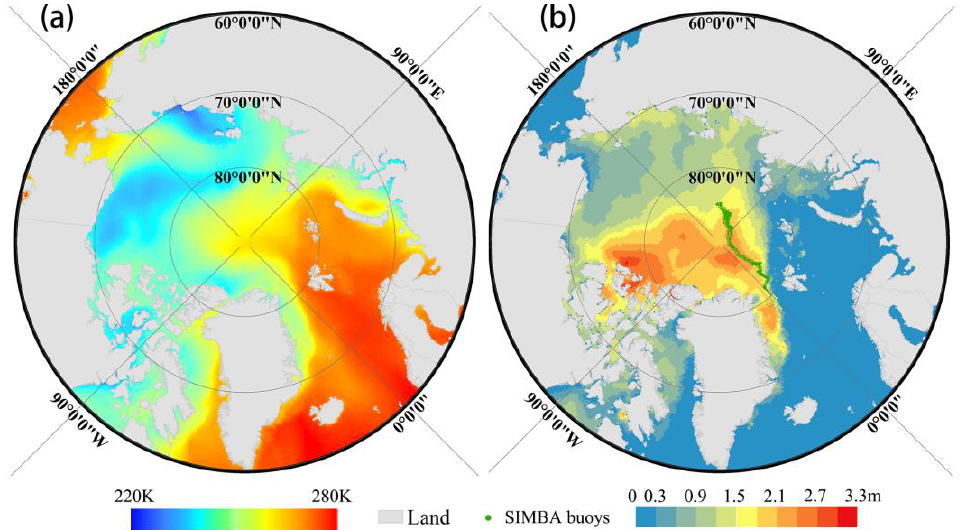
Figure 1. Study area and dataset. ( a ) An example of the Arctic 2 m temperature data distribution for 1 January 2021, obtained from the ERA5 reanalysis data; ( b ) an example of the Arctic SIT distribution on 1 January 2021, obtained from CS2SMOS. Grey regions represent the land. Green points represent the SIMBA buoys. Table 1. Information on data used in this study. Dataset